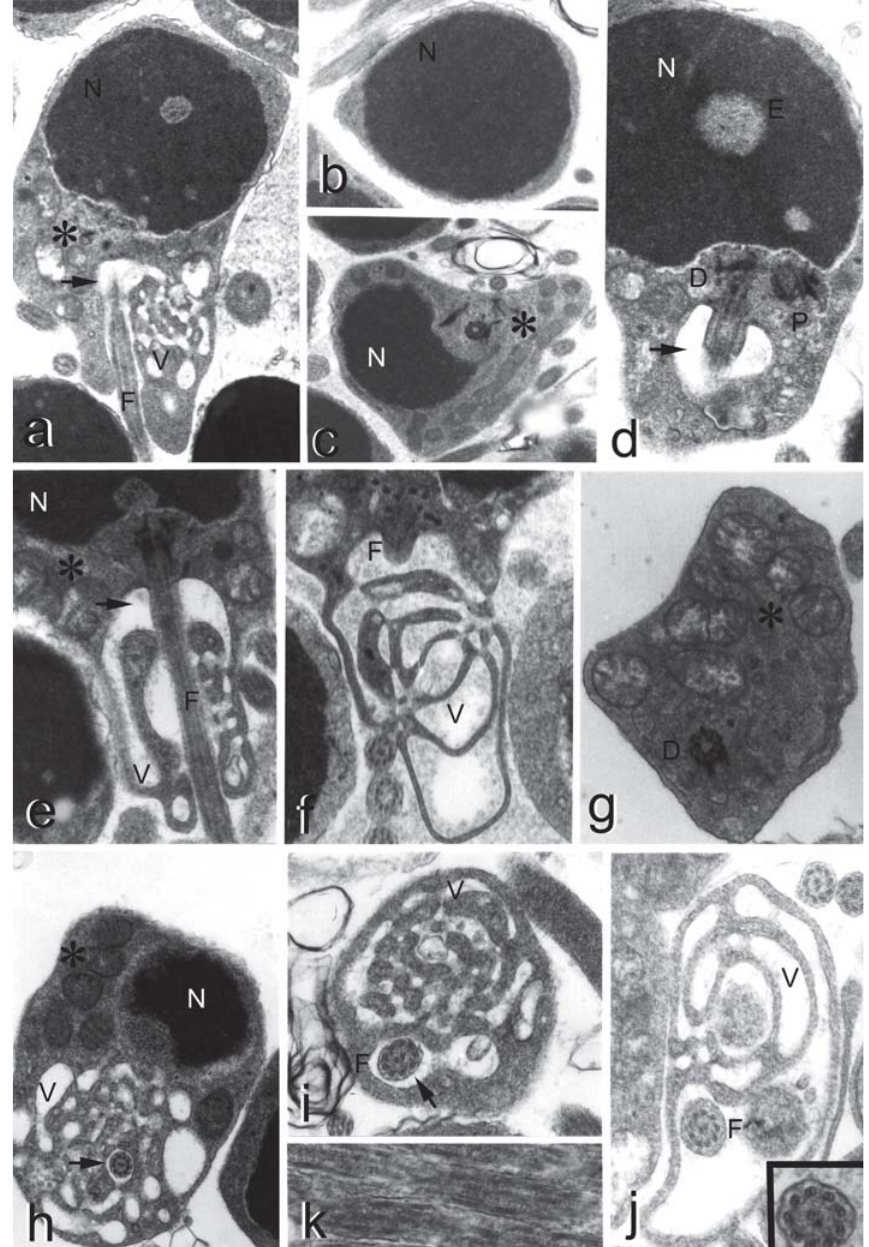
Fig. 8. Spermatozoa of Hoplosternum littorale . a ) Spermatozoon in longitudinal section. b and c ) Nucleus in cross sections. d ) Detail of centriolar arrangement. e to j ) Midpiece in longitudinal and transverse sections showing mitochondria, elongated vesicles, and cytoplasmic channel. k ) Flagellum in longitudinal section. j -inset) Flagellum in cross section showing classical (9+2) axoneme. ( a, b, h ) X 17000; ( c ) X 13800; ( d to g ) X 23000; ( i ) X 33600; ( j, k ) X 31500; ( j -inset) X 57500. D: distal centriole; E: electron-dense structure; F: flagellum; N: nucleus; P: proximal centriole; V: vesicles; Asterisk: mitochondria, Arrow: cytoplasmic